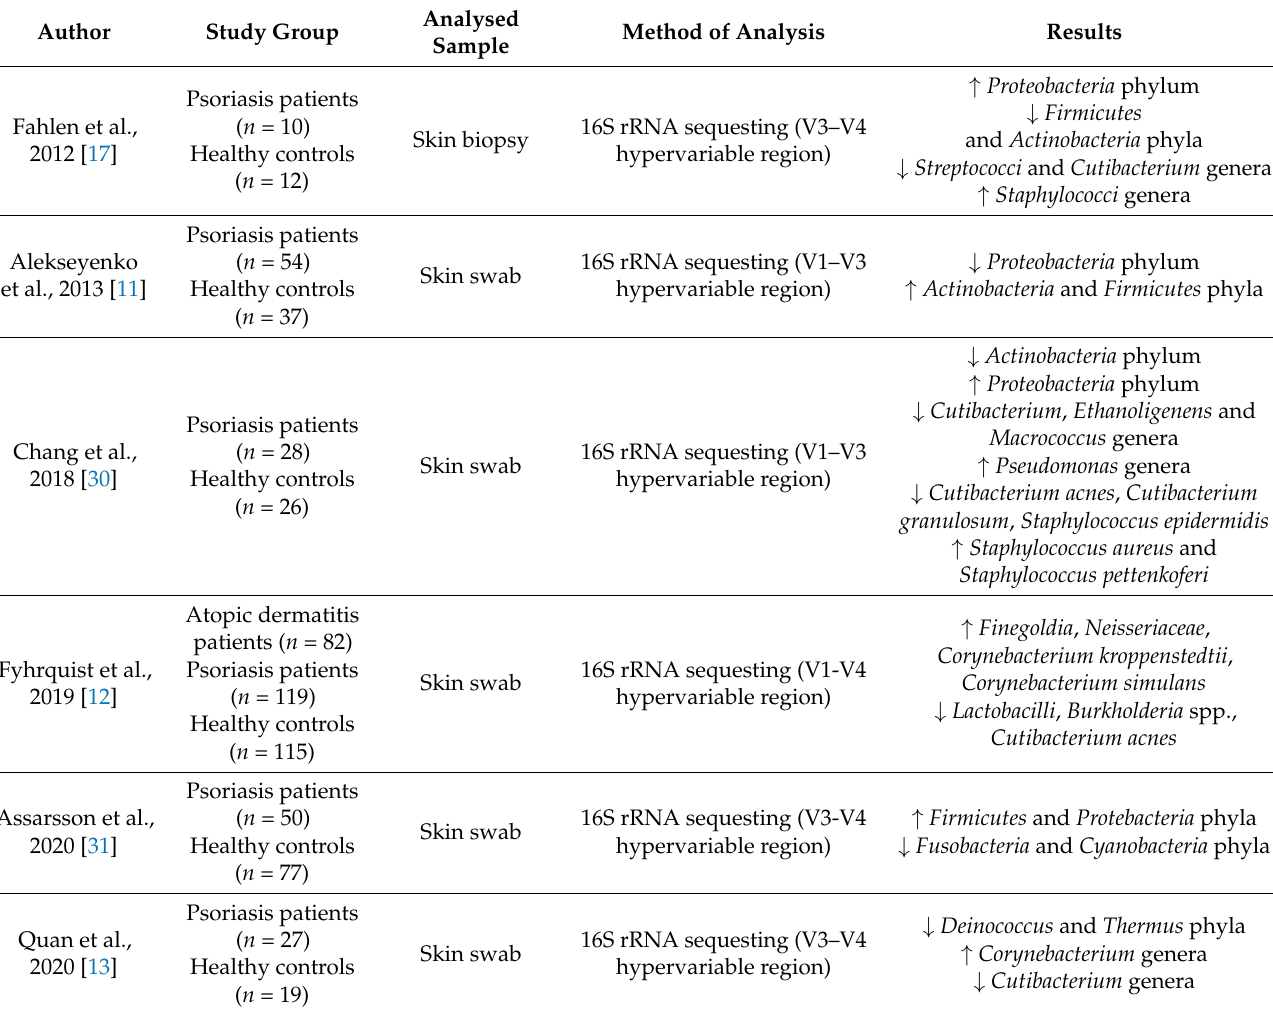
Table 1. Summary of the most relevant research studies on the skin microbiome of patients with